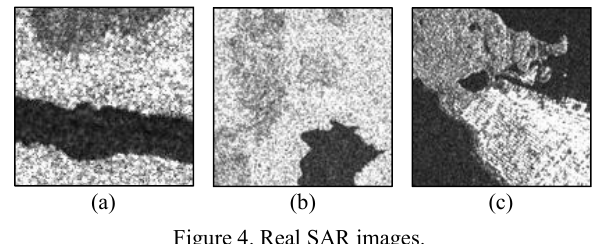
Figure 4. Real SAR images.